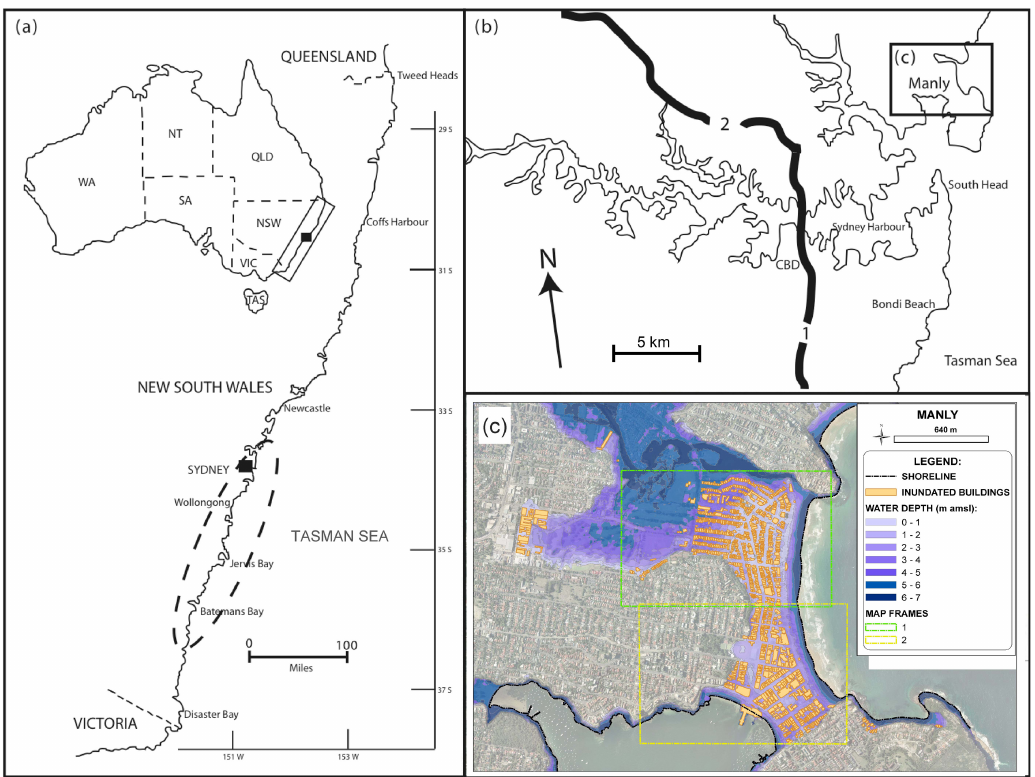
Fig. 2. (a) Broad location of the study region of Sydney located in New South Wales (NSW) on the SE coast of Australia. The hatched oval encompassing the region north of Sydney south to beyond Batemans Bay is the region reported to have been affected by Holocene megatsunami (Bryant, 2008). NSW=New South Wales, NT=Northern Territory, SA=South Australia, TAS=Tasmania, VIC=Victoria, WA=Western Australia. (b) Simplified map of the Sydney Harbour region with our specific field study area of Manly located NE of the CBD. Highways 1 and 2 are shown. (c) Detailed GIS map of our study area of Manly. Area of inundation (including relative water depths above land surface) associated with the selected tsunami scenario are shown in blue. Principal features are high-lighted and buildings inundated by the tsunami are indicated in orange. The green and yellow rectangular frames indicates the position of the vulnerability and “draft” evacuation maps shown in Figs. 3, 4, 5, and